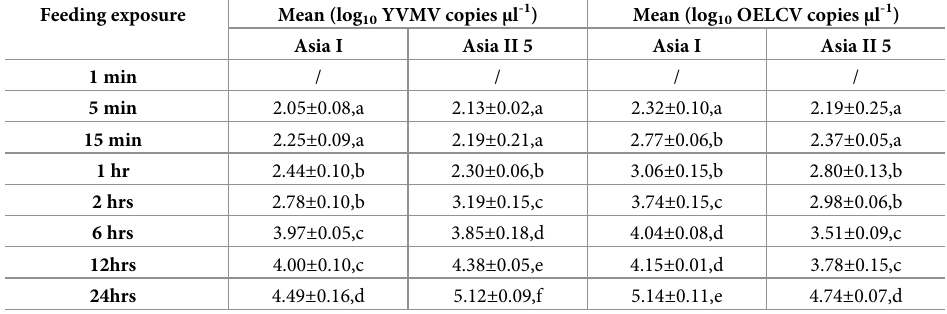
Table 2. Copies of YVMV and OELCV ingested by individual B . tabaci (Asia I and Asia II 5) genetic group at dif- ferent feeding exposure. Feeding